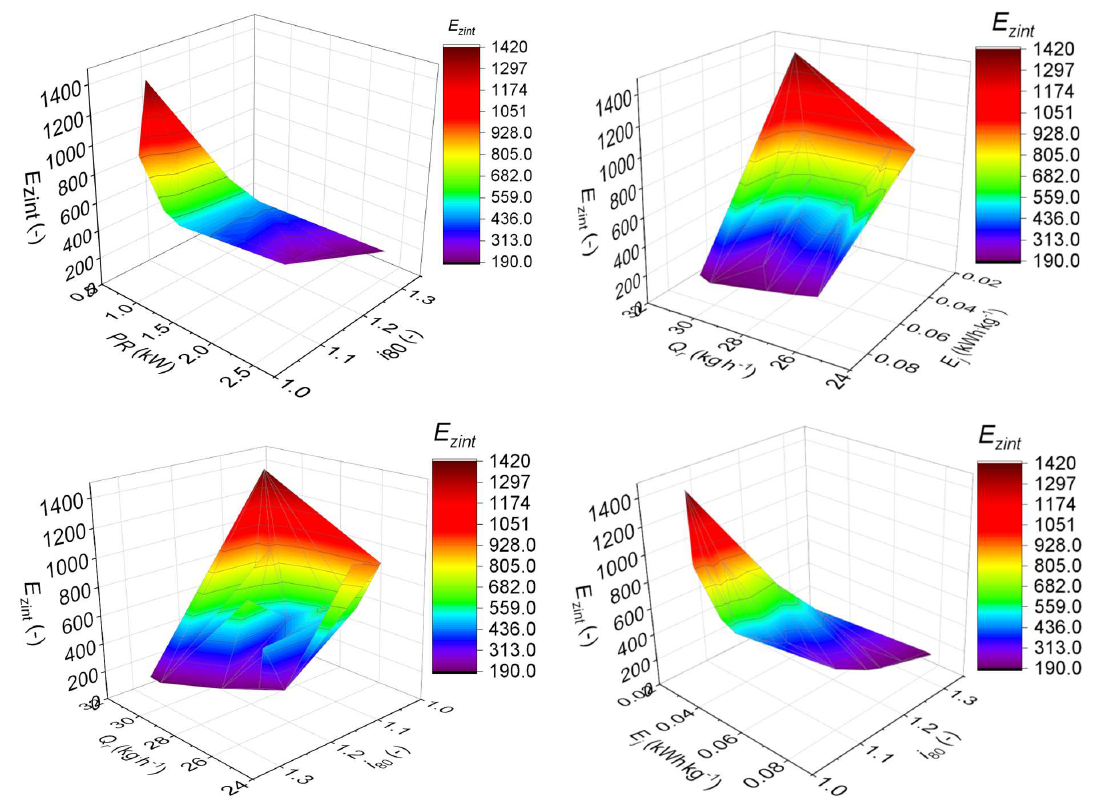
Figure 12. The integrated energy consumption of rice grinding as a function of the model components.